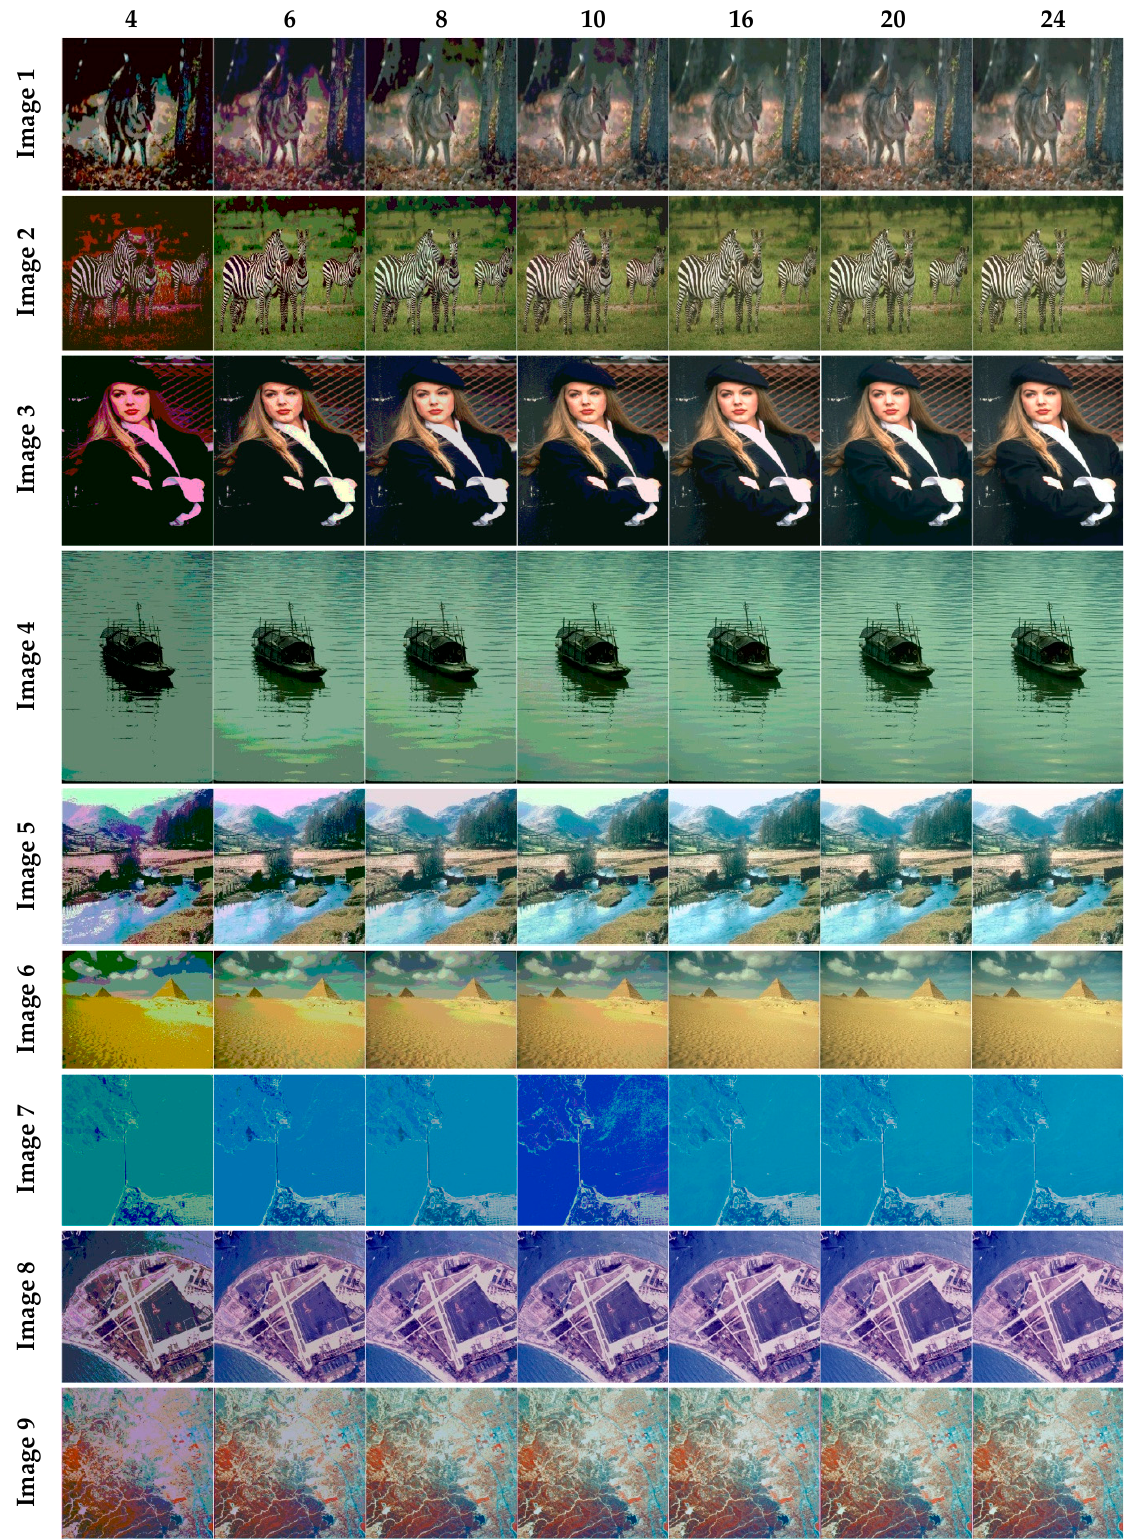
Figure 4. Segmented images of Image 1 to Image 9 for N = 4, 6, 8, 10, 16, 20, and 24 using the pro- posed method based on Kapur’s method.